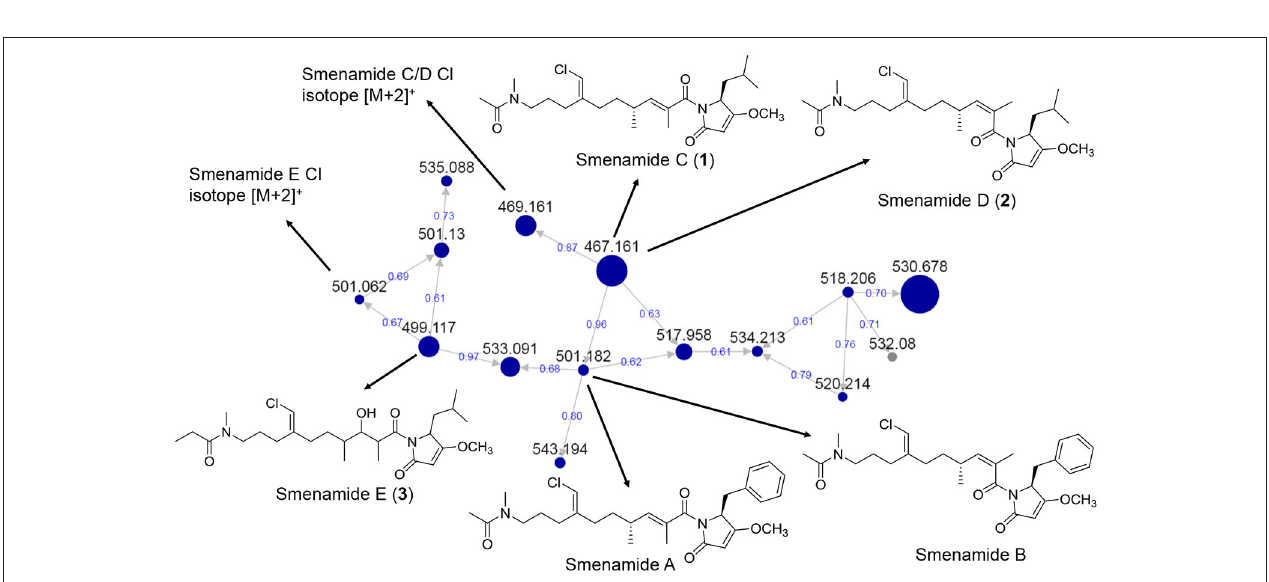
COSY correlations to the H-14 methine ( δ H 2.45), which